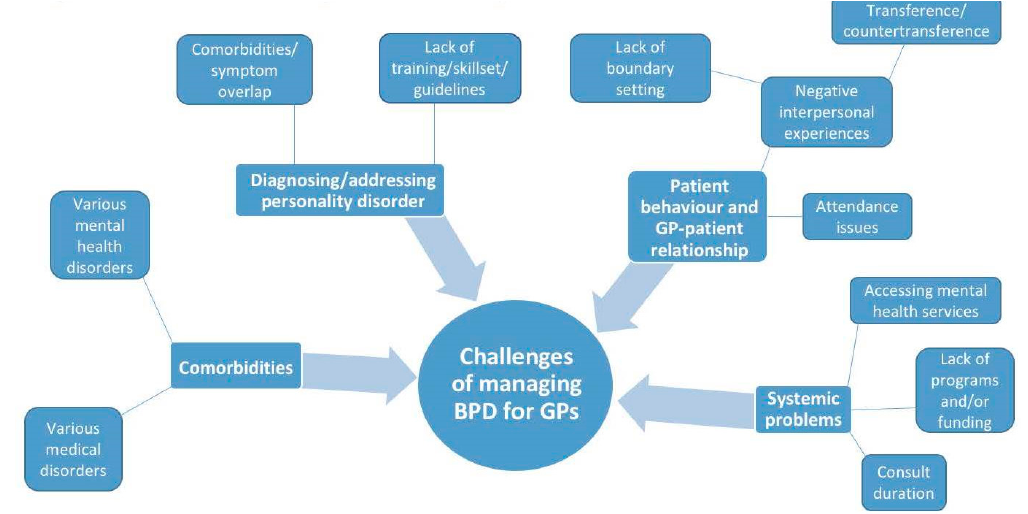
Figure 1. Summary of Findings: mind map.